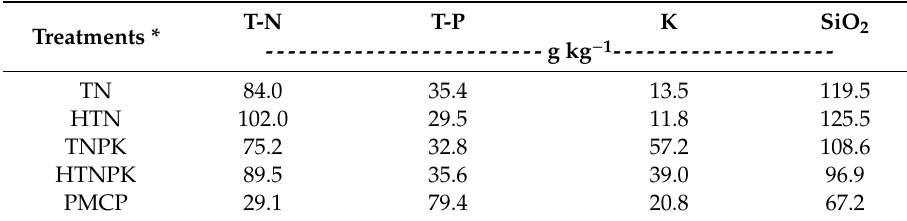
Table 2. The chemical properties of di ff erent biochar pellets before used experiments. T-N T-P K SiO Treatments *